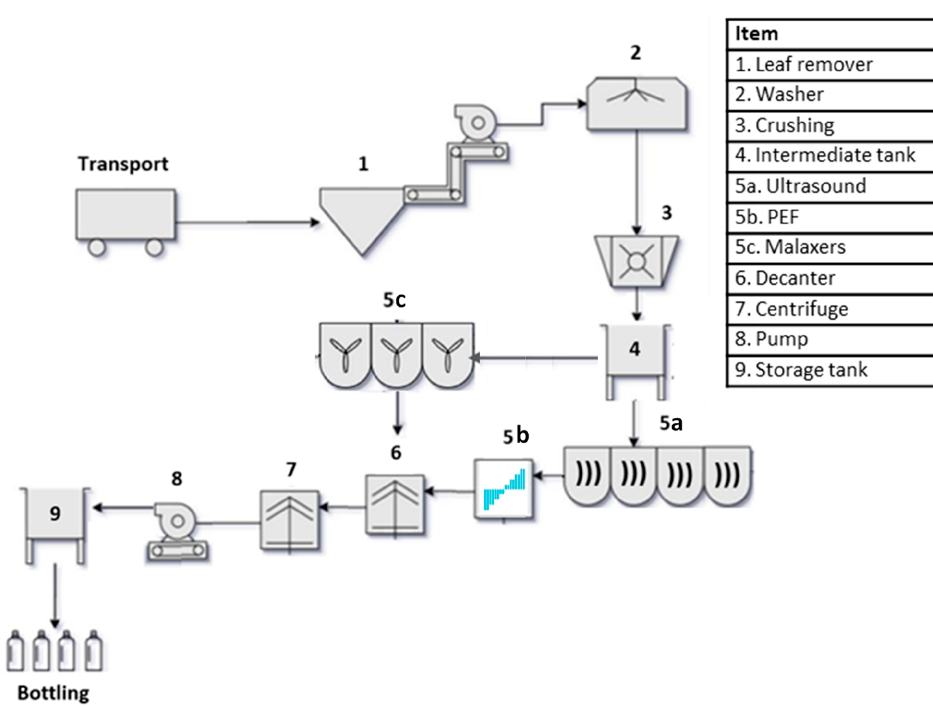
Figure 3. Flow diagram of the 2021 US-assisted industrial process, according to the adopted set-up: 5a: 4 × US; 5a + 5b: 4 × US-PEF; 5b: PEF; 5b + 5c: PEFM; 5c: CTRL.